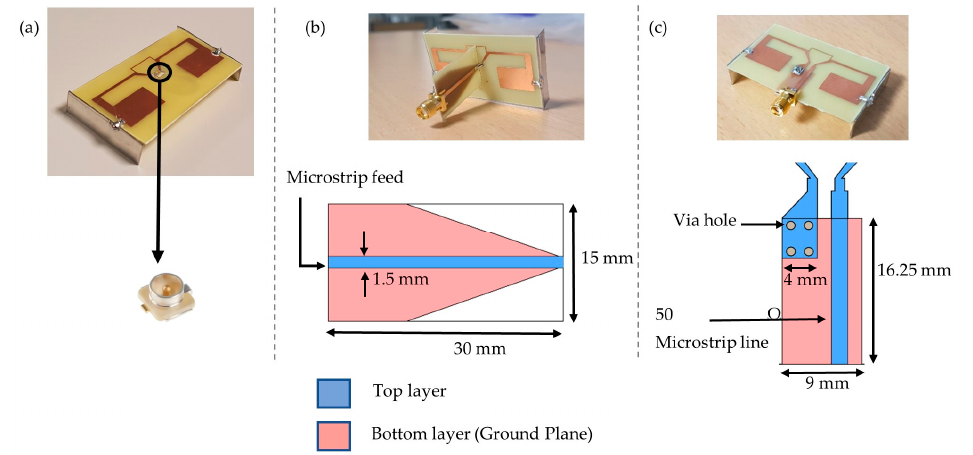
Figure 8. ( a ) Antenna with a U.FL connector named AC; ( b ) Antenna with connected tapered balun named ATB; ( c ) Antenna with integrated microstrip transition named AIT.